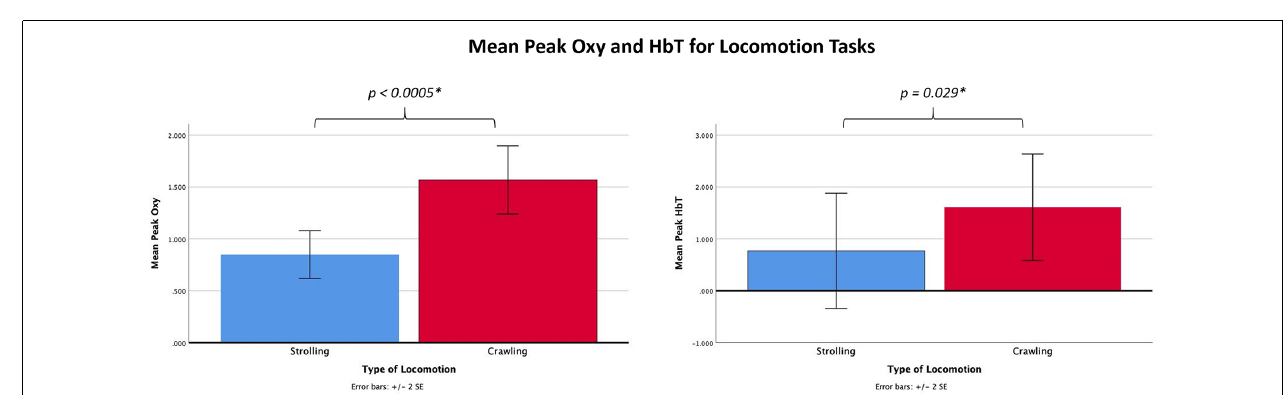
FIGURE 3 | Graphs showing the mean peak Oxy and HbT for the locomotion